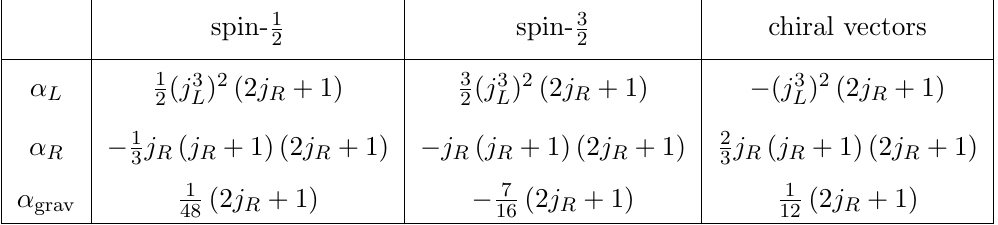
Table 2 . Contributions of a single representation to the left-, right- and gravitational Chern-Simons terms. The table should be read as (cid:11) I = sgn( M ) (cid:2) (entry of table). This is table 4.1 in 4 (cid:25)